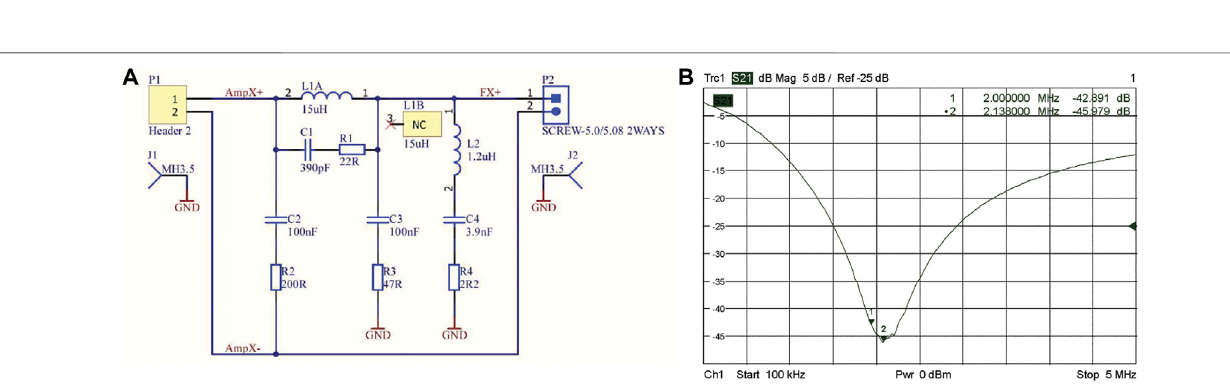
Frontiers in Physics |